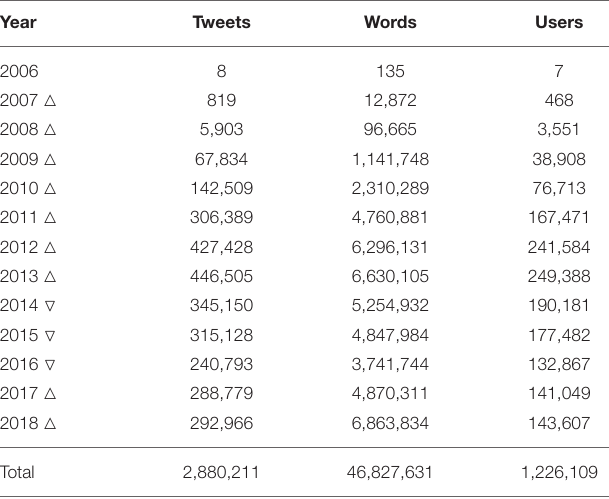
TABLE 1 | Corpus statistics for the MLT corpus, by